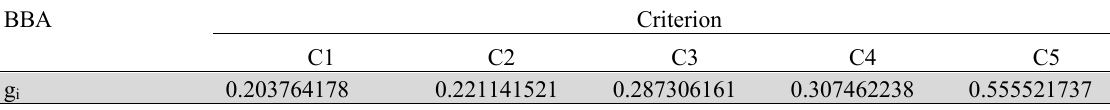
Border approximation area matrix